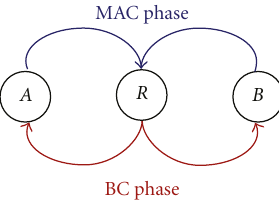
Figure 1: Model of 2-WRC in half-duplex